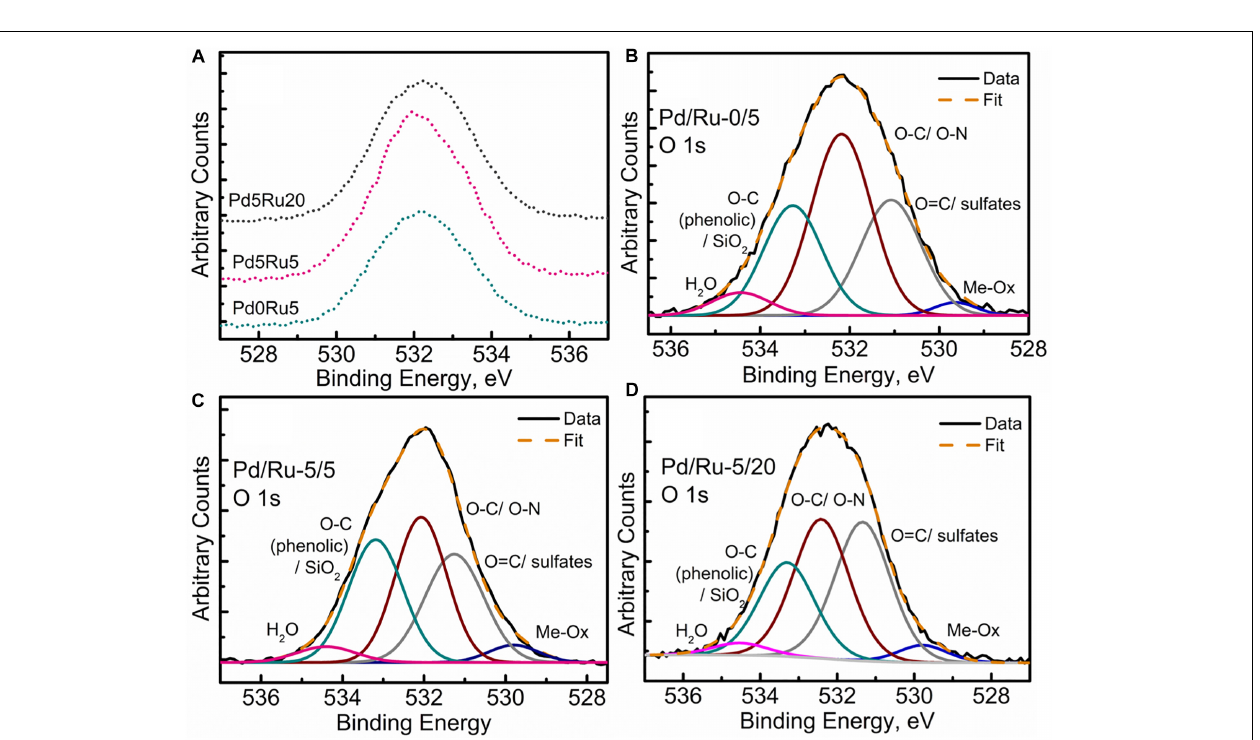
FIGURE 8 | Oxygen XPS spectra showing (A) comparison of high resolution O 1s region for all three samples, (B) O 1s peak fitting for low Ru only sample, (C) O 1s peak fitting for low Pd and low Ru loading sample, (D) O 1s peak fitting for low Pd and high Ru loading sample.